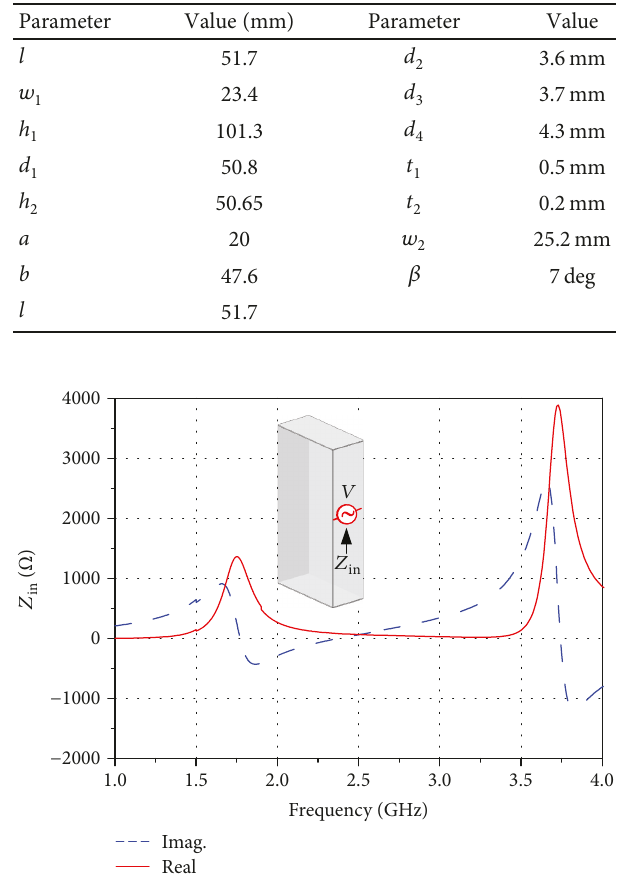
Figure 2: Input impedance as the vertical slot is excited directly by a voltage